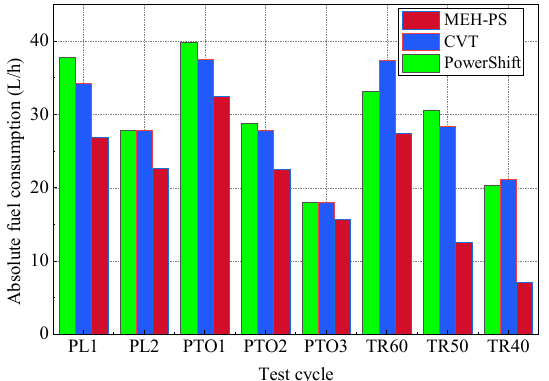
Figure 22. Fuel consumption of tractors equipped with different transmissions in different test cy- cles.